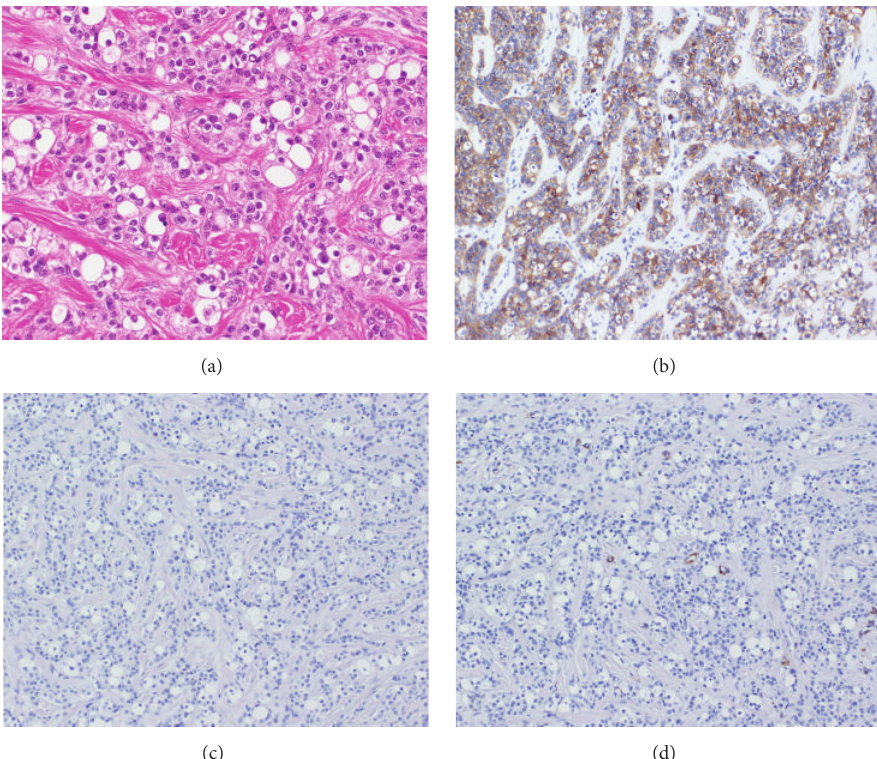
Figure 4: Histopathological and immunohistochemical findings ((a) HE stain × 200, (b)–(d) immunohistochemical stain × 200; (b) pancytokeratin (AE1/AE3); (c) S-100; (d) SMA). Proliferation of tumor cells with clear cytoplasm organized in trabeculae, cords, or solid nests surrounded by hyalinizing stroma. The nuclei of the cells were small and round in shape. Tumor cells were stained intensely with pancytokeratin, but not S-100 and